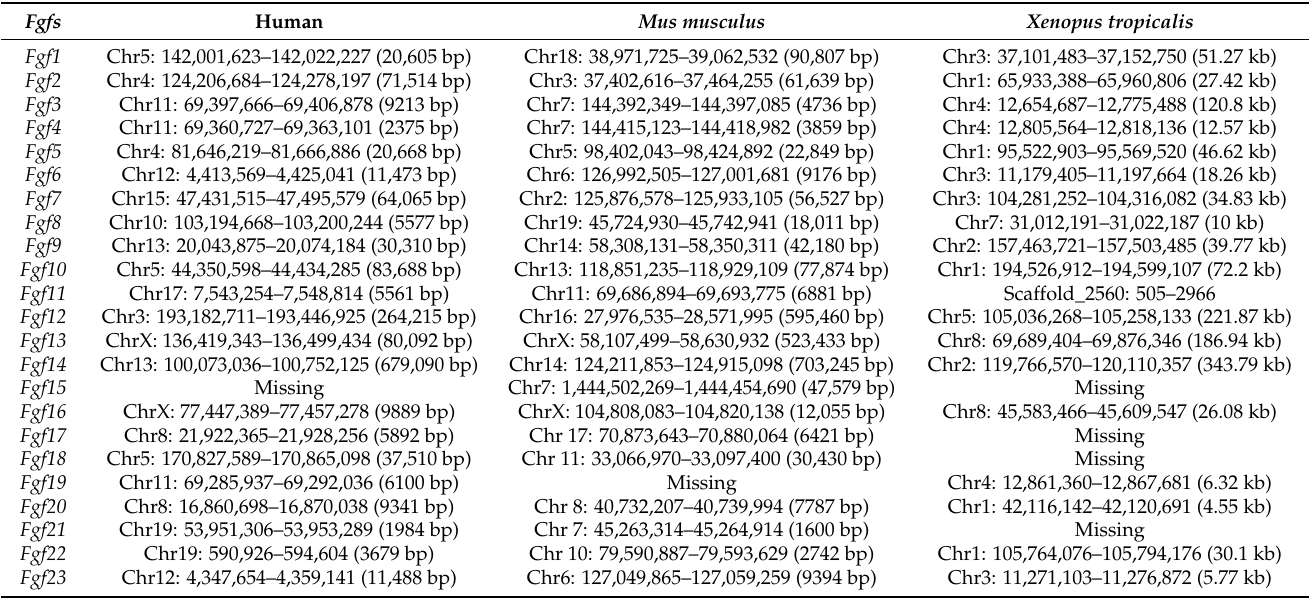
Table 1. Chromosomal location of FGF ligands in different vertebrate species. Information on the genome for human, mouse, and Xenopus models has been sourced from NCBI GeneBank, Mouse genome informatics, and Xenbase database,